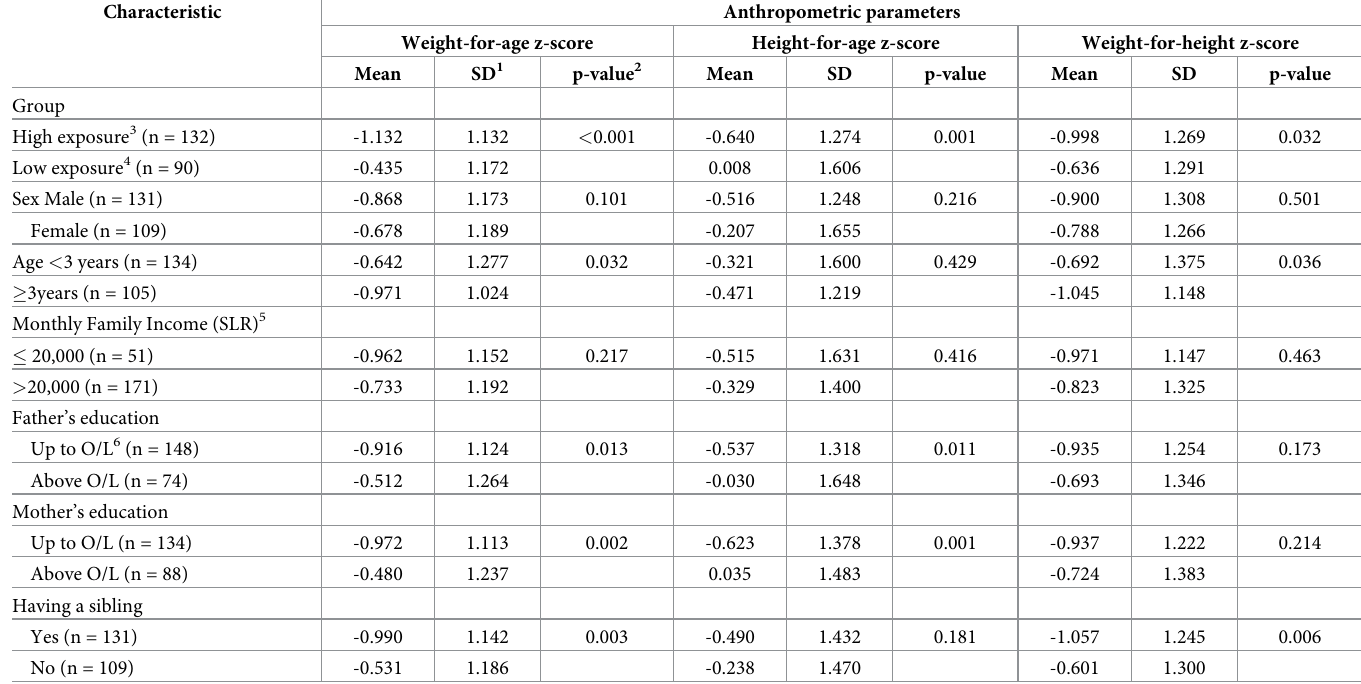
Table 3. Association between anthropometric indices and socio-demographic characteristics of